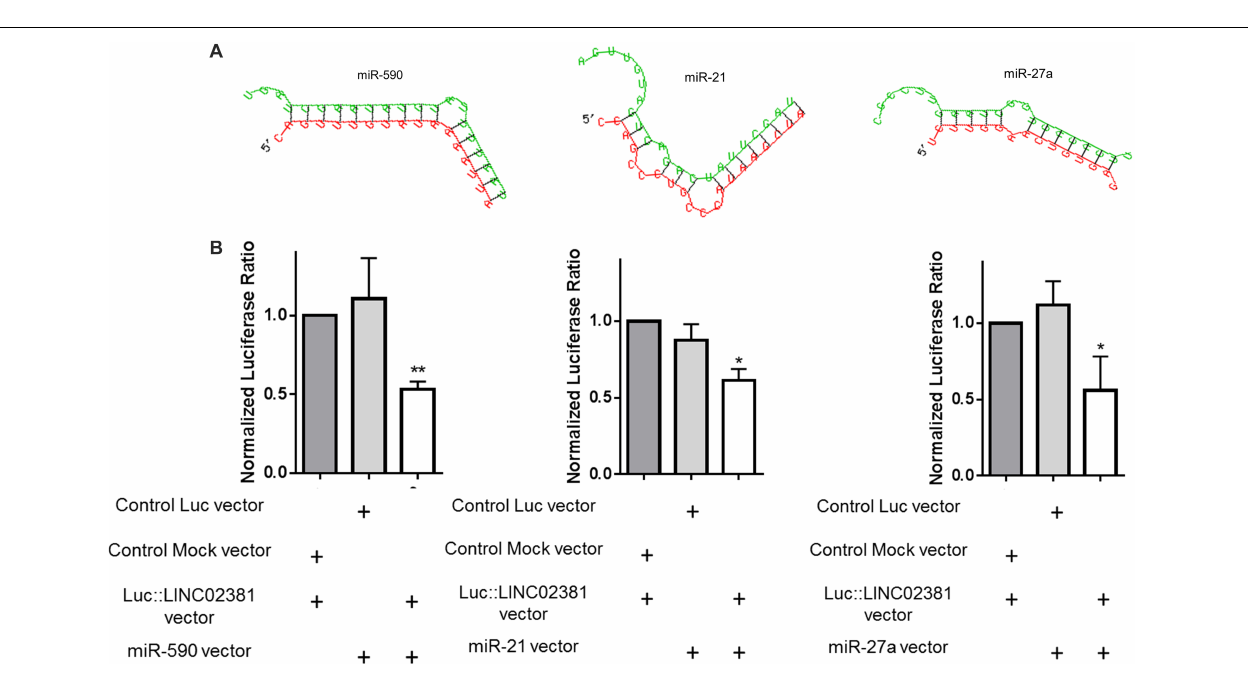
FIGURE 2 | Bioinformatics and experimental evidences of LINC02381 expression alteration in gastric cancer specimens. (A) UCSC genome browser shots displaying LINC02381 position on human genome. (B) TCGA data analysis showed lower expression of LINC02381 in gastric adenocarcinoma tissues, compared to their related normal ones, adopted from Starbase v3.0. (C) Expression status of LINC02381 in gastric cancer and paired normal gastric tissues, detected by RT-qPCR. Data represent the mean ± SEM from three independent experiments. ∗ P < 0.05.